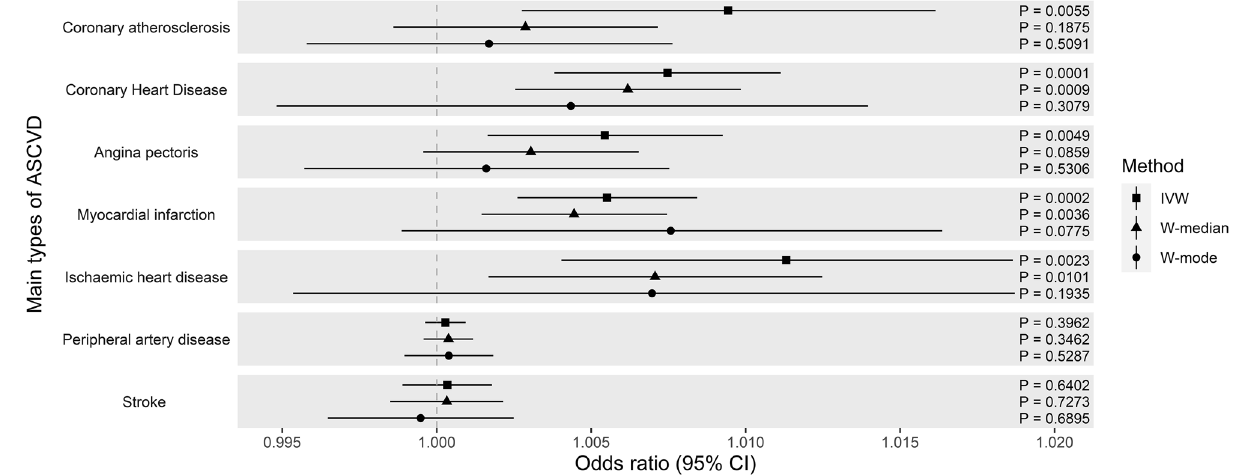
Figure 2. Causal estimates of CAC on main types of ASCVD outcomes (odds ratio with 95% confidence interval) using the UK Biobank